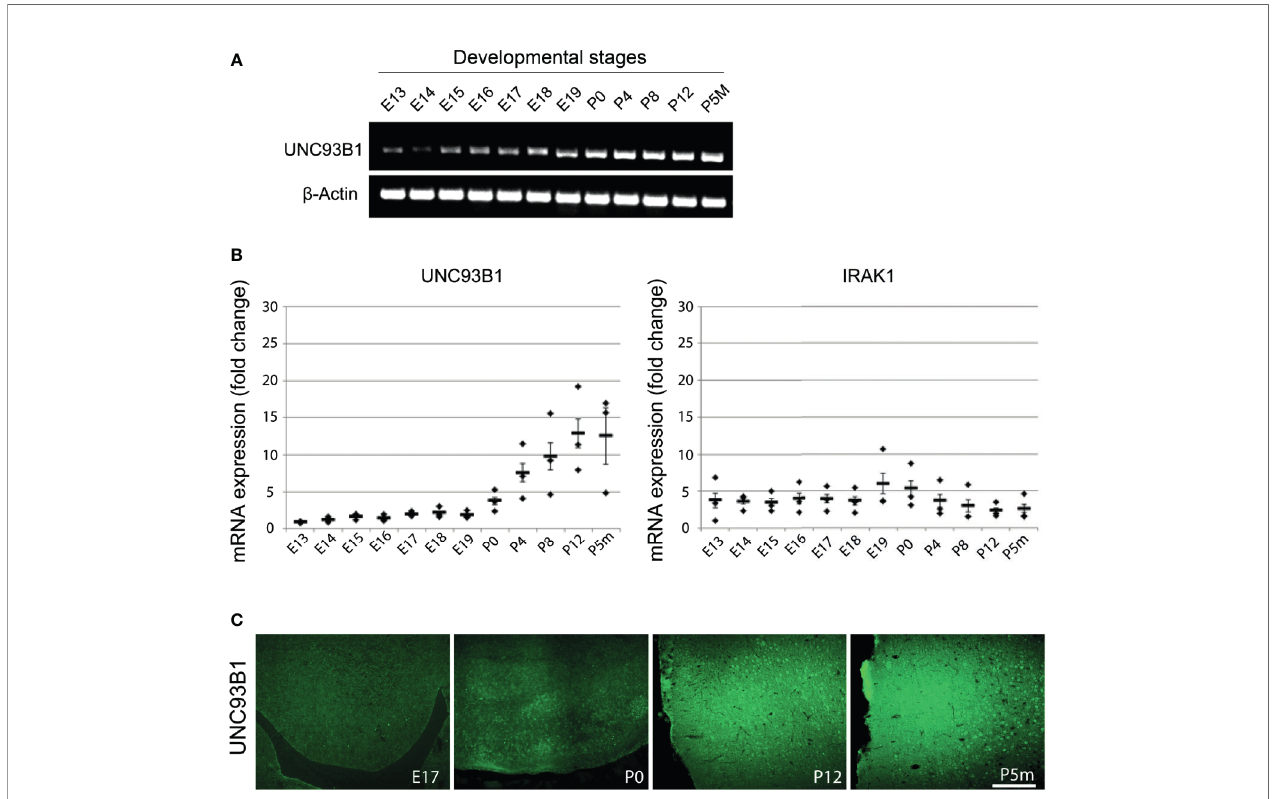
FIGURE 2 | Expression of UNC93B1 in the mouse brain increases during development. Brain homogenates from C57BL/6 mice at various embryonic (E), postnatal (days after birth, P), and adult (age of months, Pm) stages, as indicated, were assayed by endpoint RT-PCR (A) and quantitative real-time PCR (B) using primers for Unc93b1 and IRAK1 . Relative quanti fi cation was assessed using the formula 2 – D CT and by normalizing the amount of the target gene to the housekeeping genes b - actin (A) and GAPDH (B) . The mean value of E13 was set to 1-fold induction, and mean values of all other developmental stages were related to E13 ( n = 3). Results are presented as mean ± SD. (C) Immunolabeling of the C57BL/6 cerebral cortex at different developmental stages, as indicated, with the UNC93B1-C antibody. Scale bar, 200